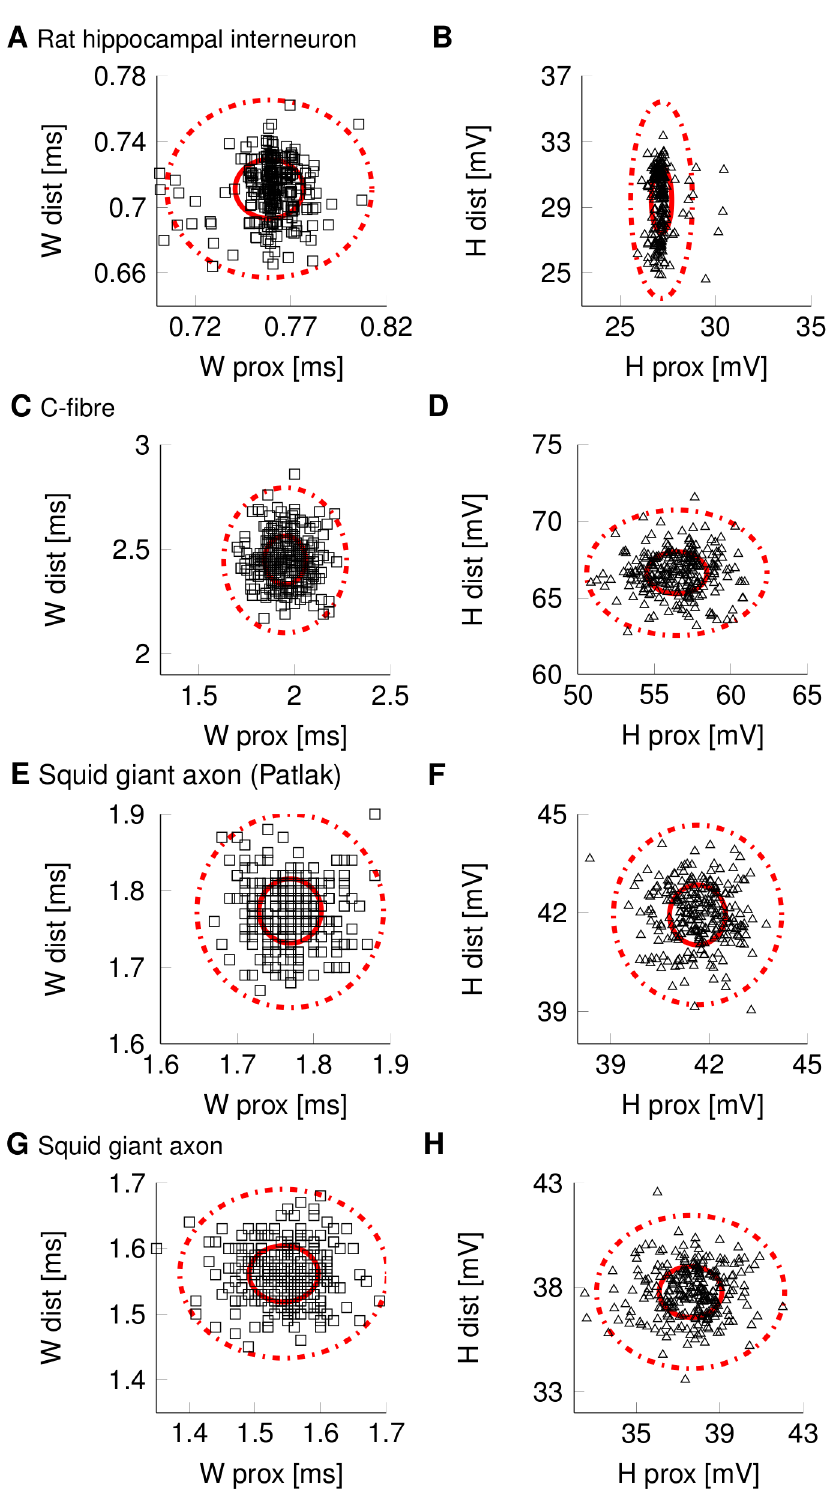
Figure 2. Random variability of AP waveform in thin axons (d=0.2 m m) of four different types. Subfigures display data for N . 200 single APs triggered by identical stimuli and initial conditions (thick circle, 1 6 SD; dotted circle 3 6 SD). (A) Distribution of AP width and (B) AP height for rat hippocampal interneuron model axon. (C) Distribution of AP width and (D) AP height for C-fibre axons. (E) Distribution of AP width and (F) AP height for squid giant axons with Patlak channels. (G) Distribution of AP width and (H) AP height in squid giant axons.